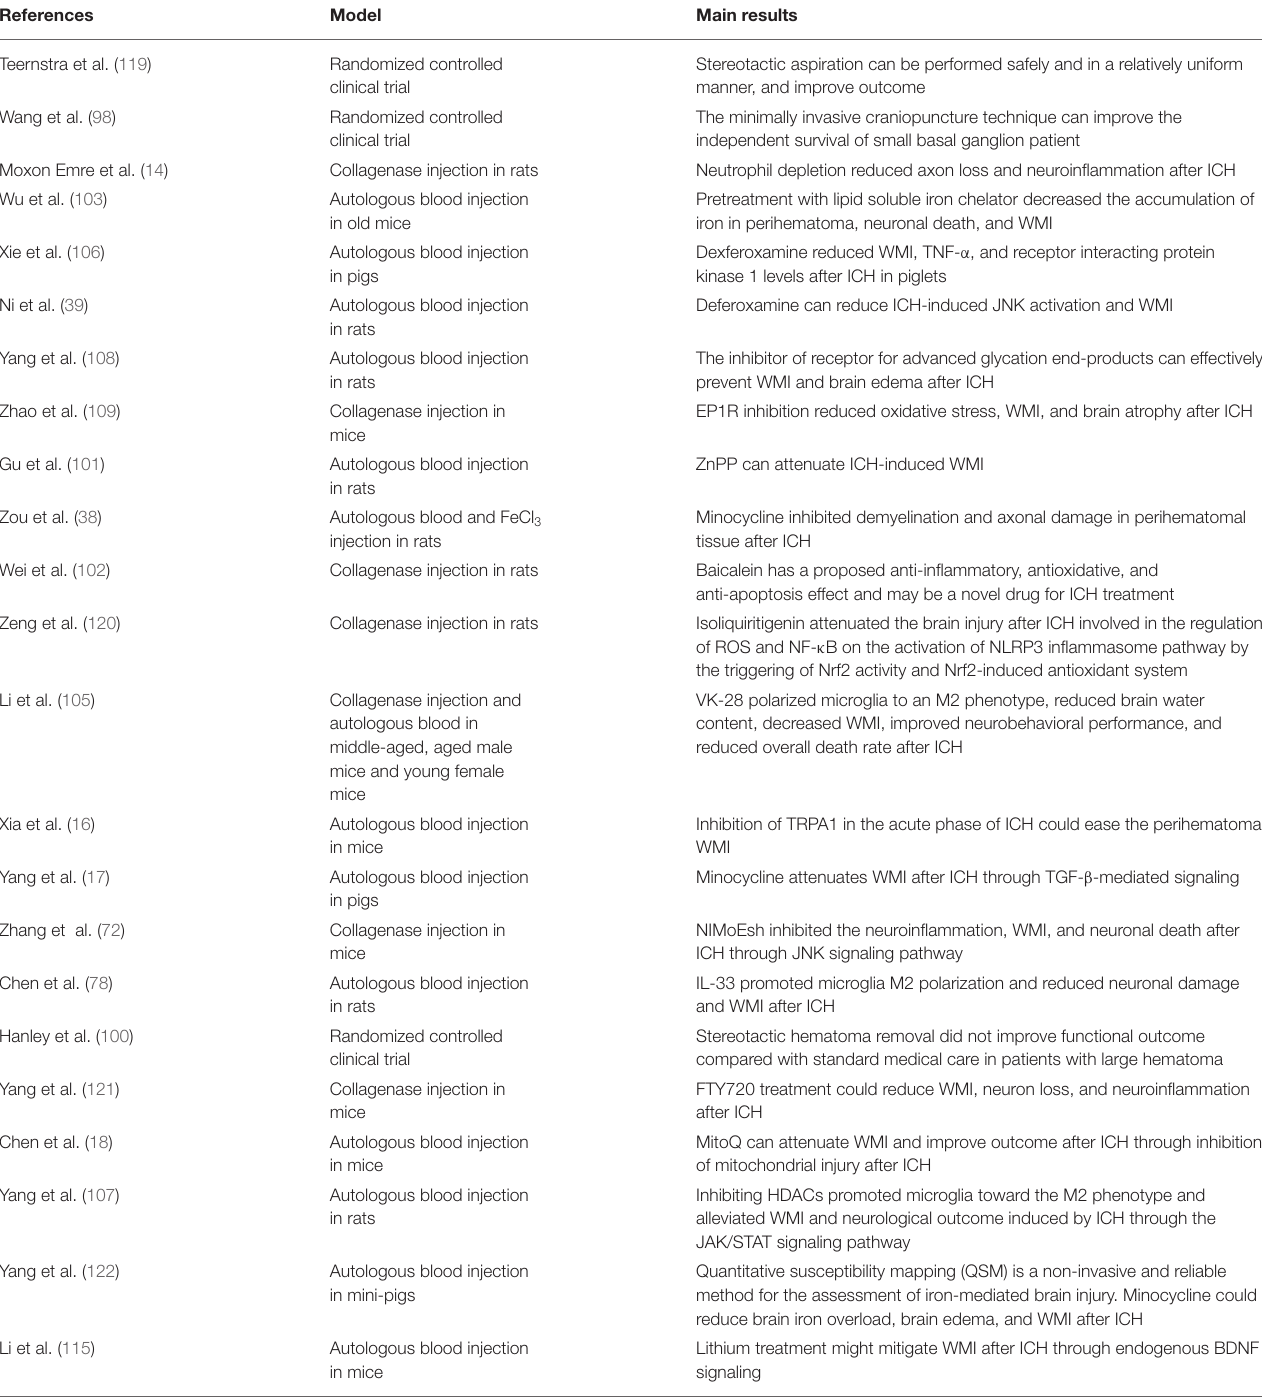
TABLE 1 | The treatment of WMI after